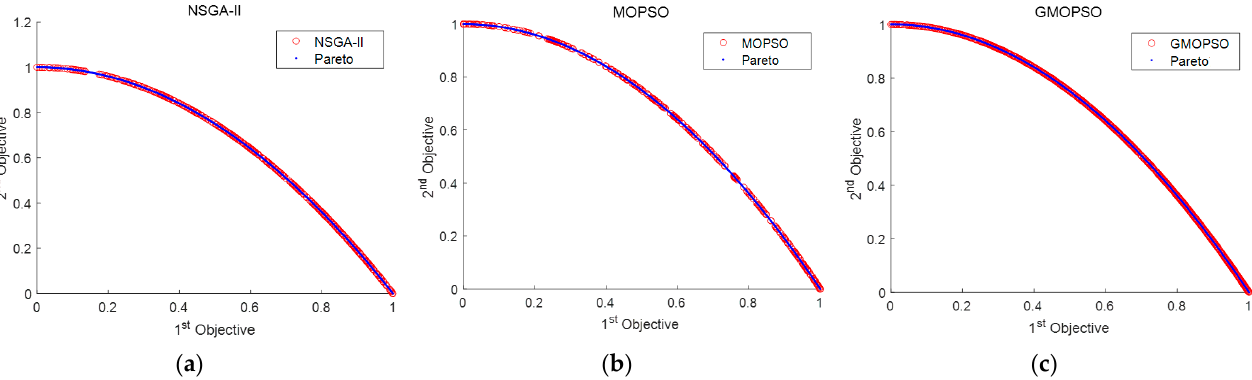
Figure 5. Test results of function ZDT2. ( a ) Pareto solutions of NSGA-II; ( b ) Pareto solutions of MOPSO; ( c ) Pareto solutions of GMOPSO.